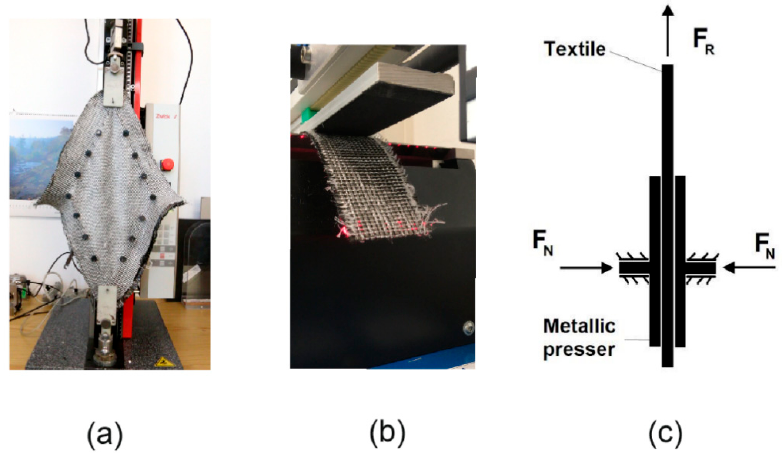
Figure 7. ( a ) Tensile machine with a picture frame 200 × 200mm 2 . ( b ) Cantilever test machine. ( c ) Principle of friction test.